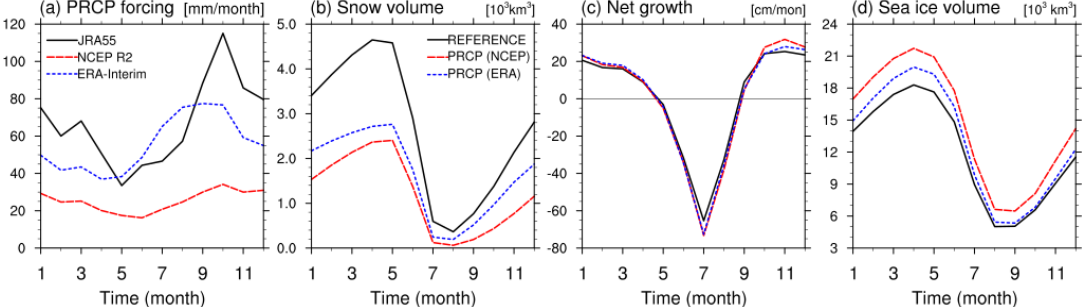
Figure 6. Results of the PRCP experiment. ( a ) Precipitation forcing (similar to Figure 1e), ( b ) snow volume, ( c ) net growth rate of sea ice, and ( d ) sea ice volume. ( c,d ) use the same labels as ( b